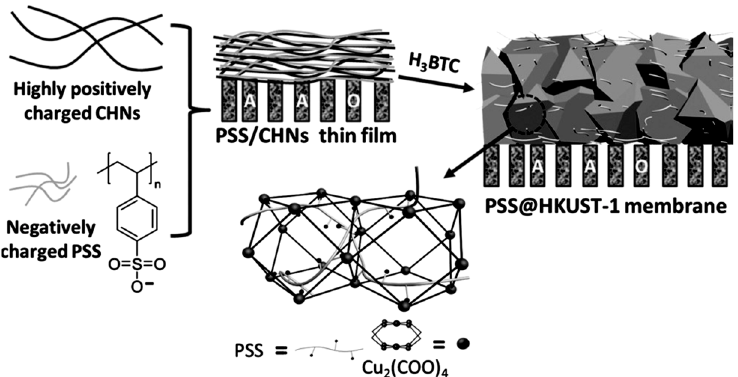
Figure 13. Preparation of PSS-threaded HKUST-1 membranes. CHNs = copper hydroxide nano- strands. AAO = anodic alumina, the gray bars are the anodic alumina oxide membrane [105].